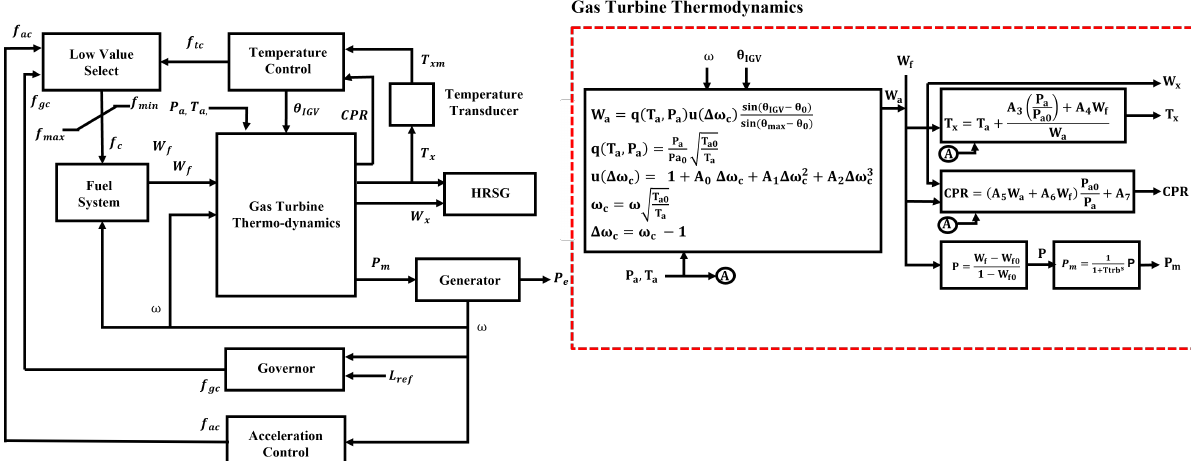
Figure 11. Frequency-dependent model for gas turbine operation